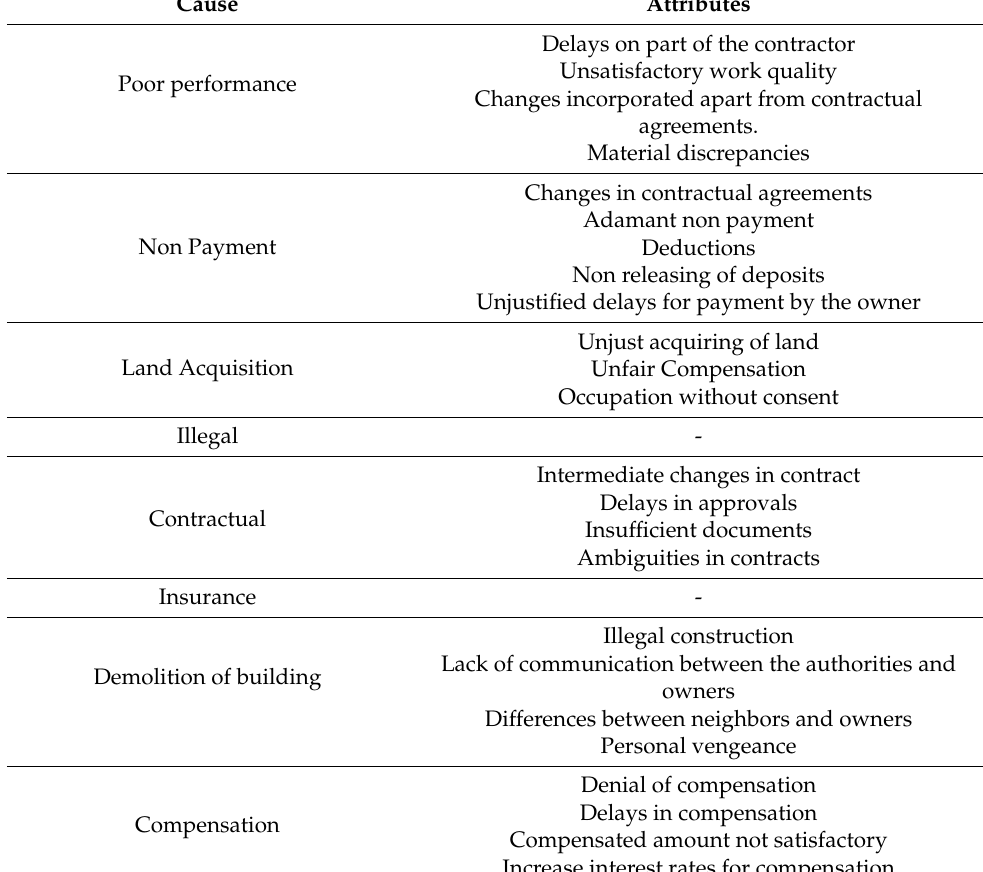
Table 2. Attributes of disputed